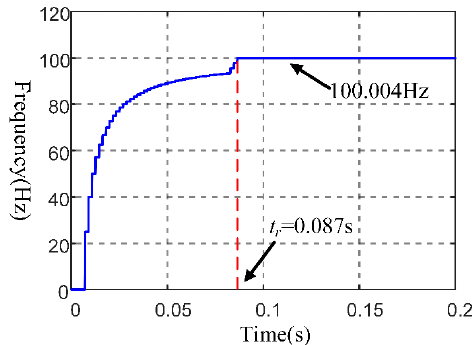
Figure 6. Simulation result of the novel frequency estimator.